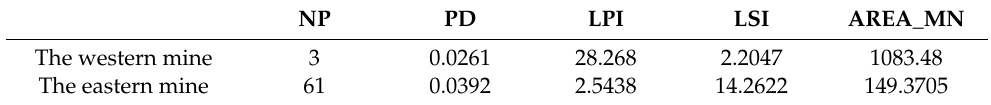
Table 1. Industrial and mining land class level